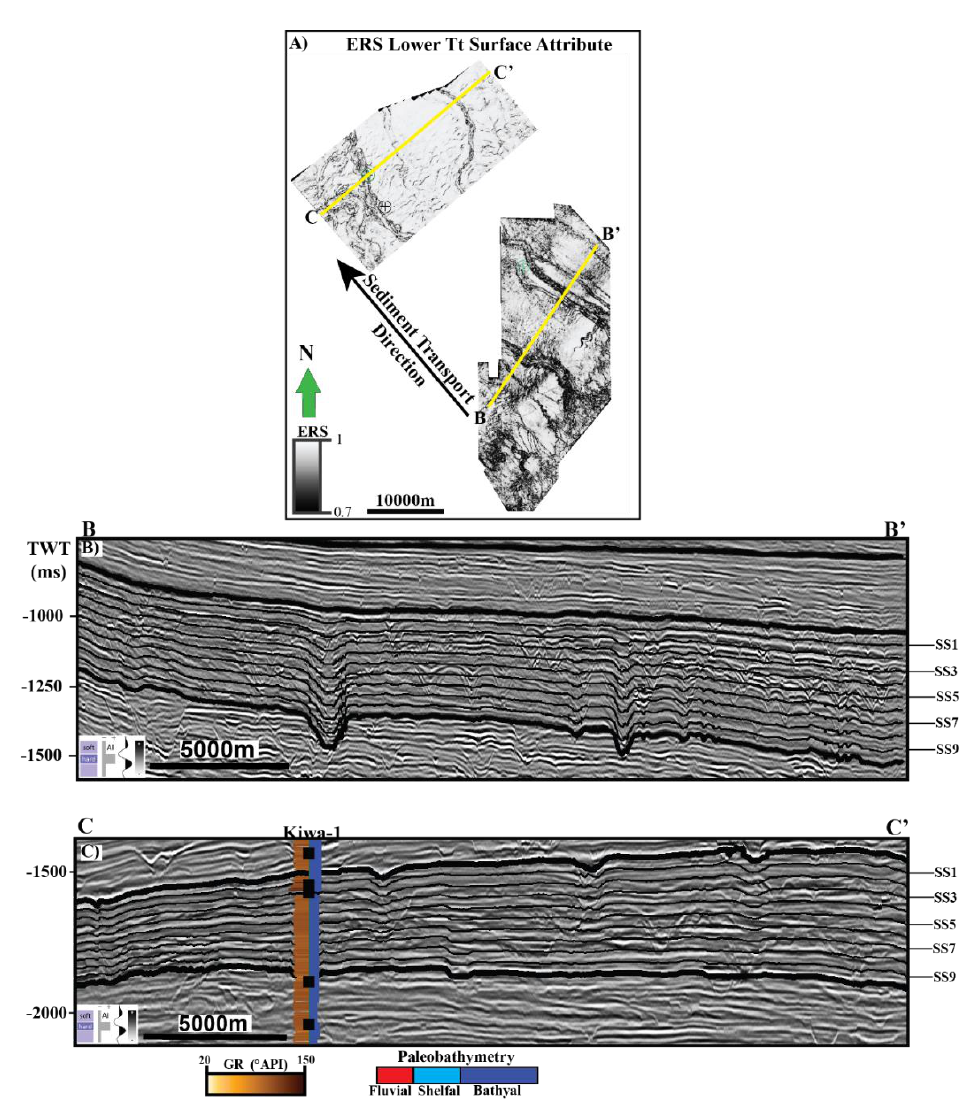
Figure 4. ( A ): Map view of the lower Tongaporutuan (Tt) surfaces with the energy ratio similarity (ERS) attribute extracted along them. ( B ): Seismic section perpendicular to sediment transport direction in the Pipeline-3D survey displaying the resulting stratal slices. ( C ): Seismic section perpendicular to sediment transport direction in the Hector-3D survey displaying the resulting stratal slices.